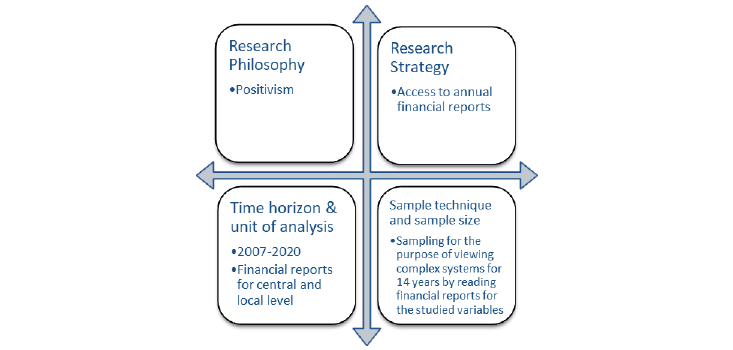
Figure 1. Instruments and research methodology